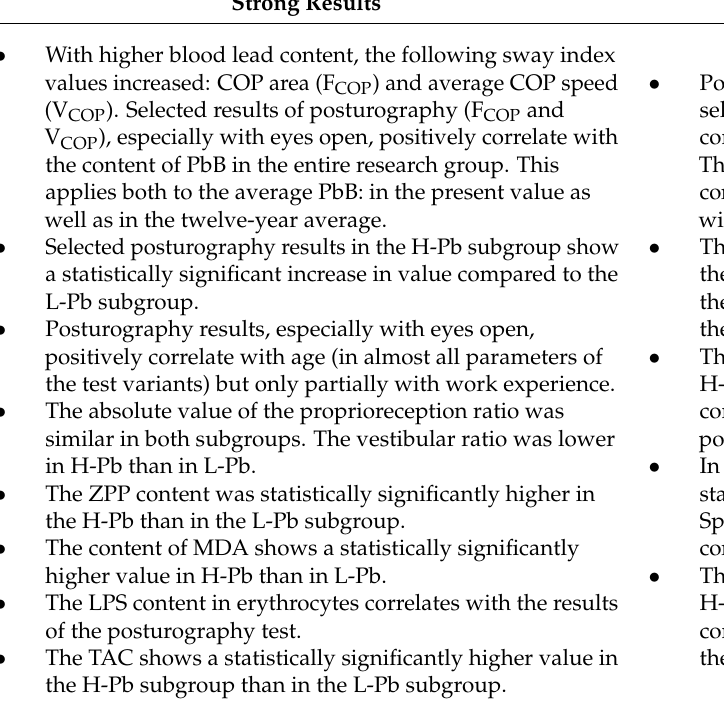
Table 5. Summary of the